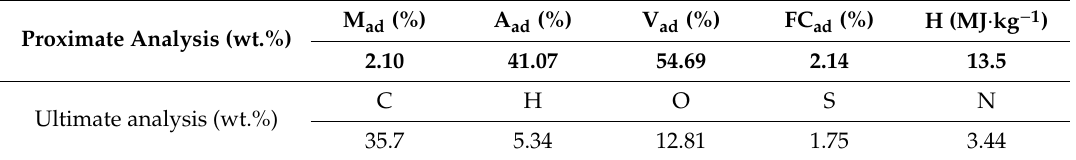
Table 1. Proximate and ultimate analyses of the sewage